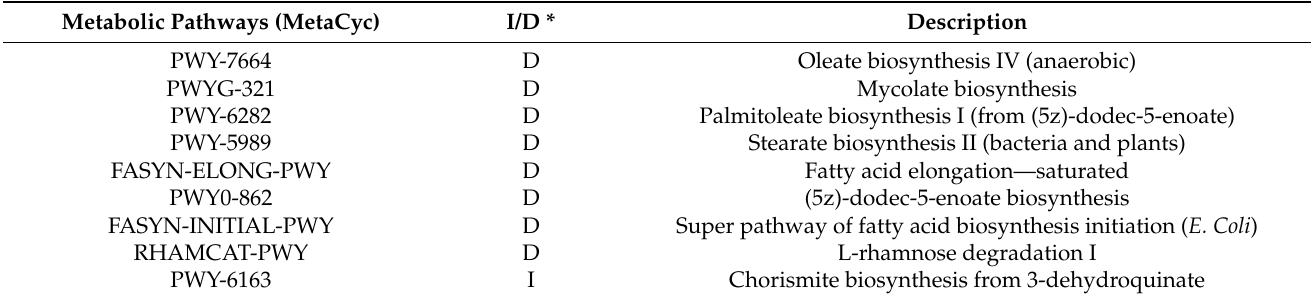
Table 1. Changes in metabolic activities in response to differences in the microbiome of at least 3